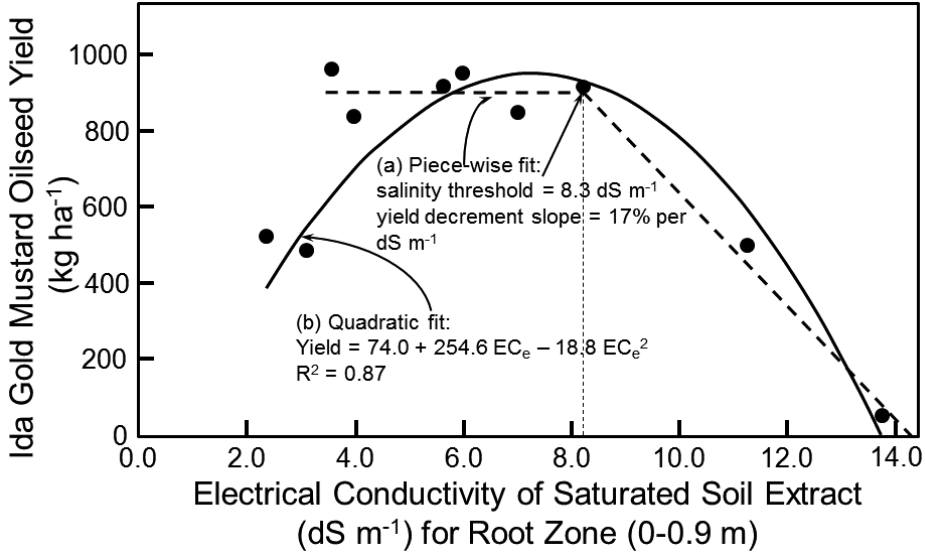
Figure 5. Salt tolerance models for Ida Gold mustard oilseed: ( a ) two-piece linear salt tolerance model (thick dashed line) of Maas and Hoffman [18] and ( b ) quadratic salt tolerance model (solid line). Thin dashed line indicates the salinity threshold of the two-piece linear salt tolerance model.